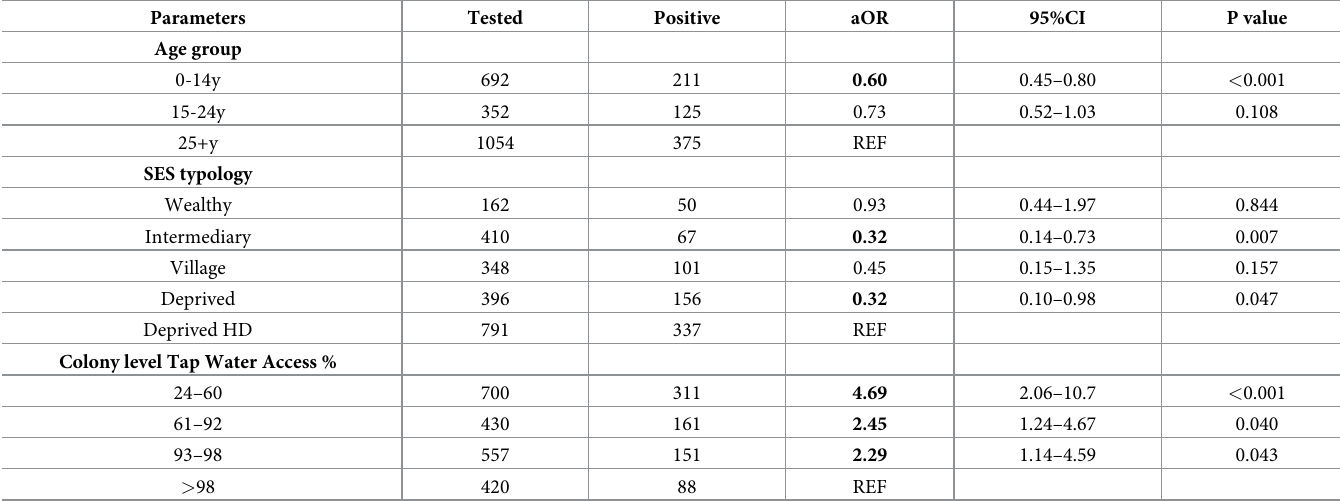
Table 2. Association of parameters with previous dengue infection (IgG) in the multivariate analysis. Parameters Tested